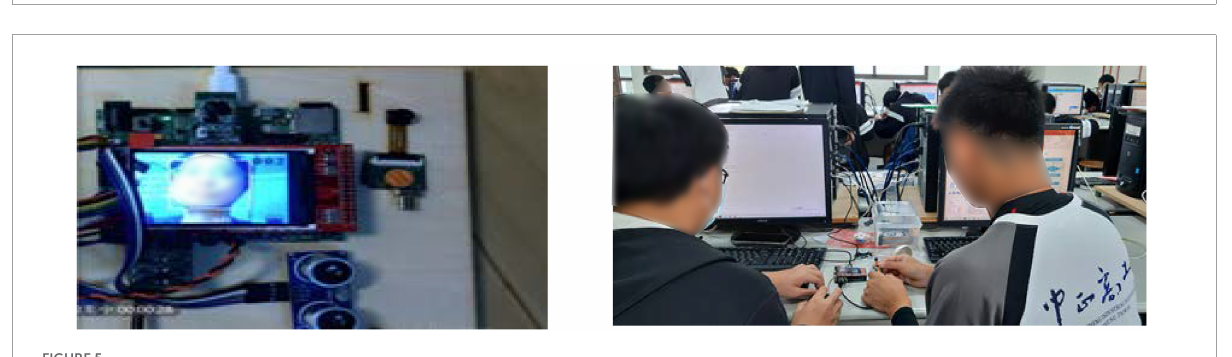
FIGURE5 The practical operation practices of image recognition